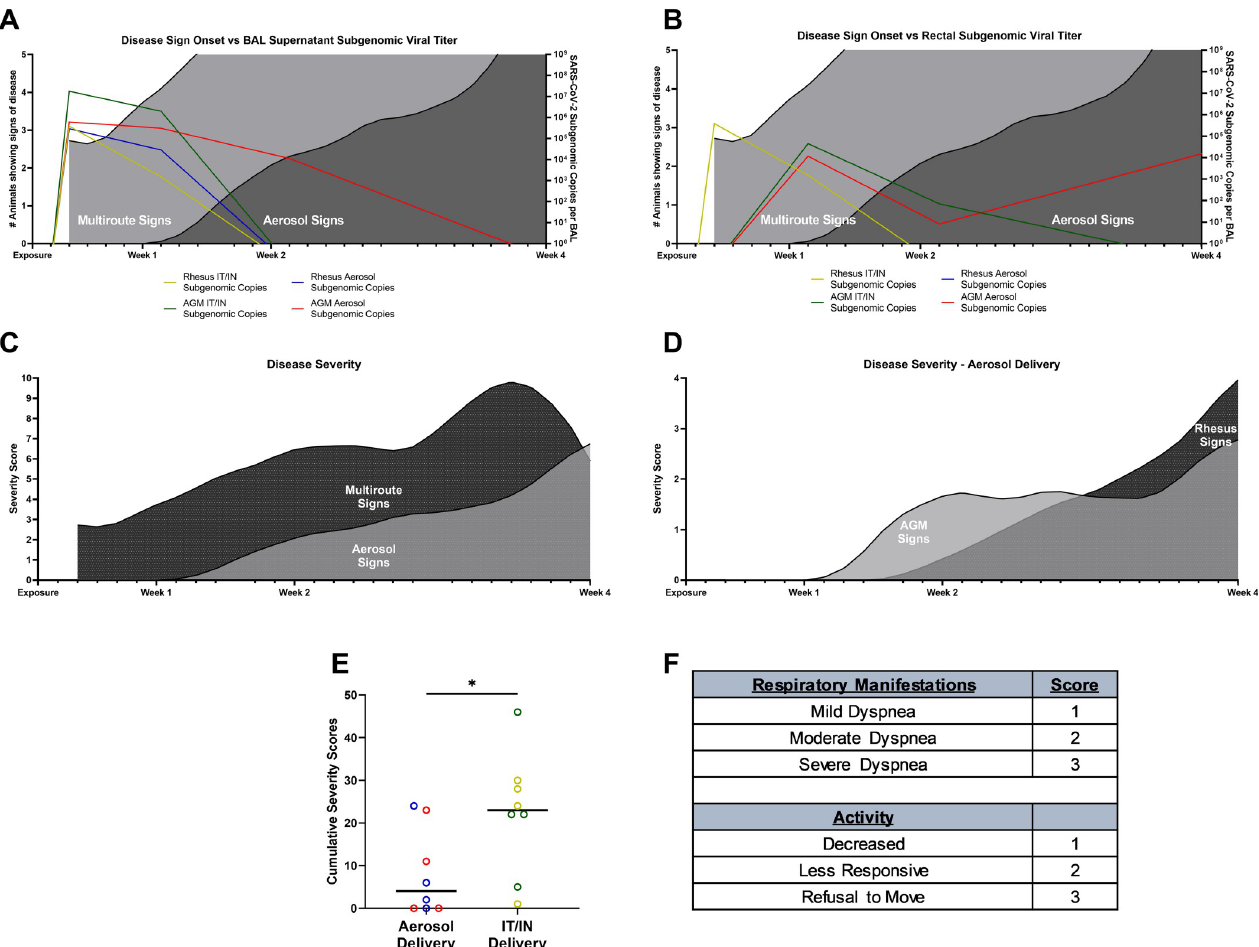
Fig 6. Clinical Disease Severity Scores. Signs of disease present in each cohort over time. Number of animals showing signs of disease along with subgenomic viral loads in A) BAL supernatant and B) rectal swabs. Severity scores per group in C) both delivery cohorts and D) aerosol cohort split into species. E) Cumulative severity scores per delivery cohort. F) Simplified scoring system used for cohorts. Curves in figures were smoothed. Comparisons made using Welch’s t-test. Asterisks represent significant comparisons ( � , p < 0.05).